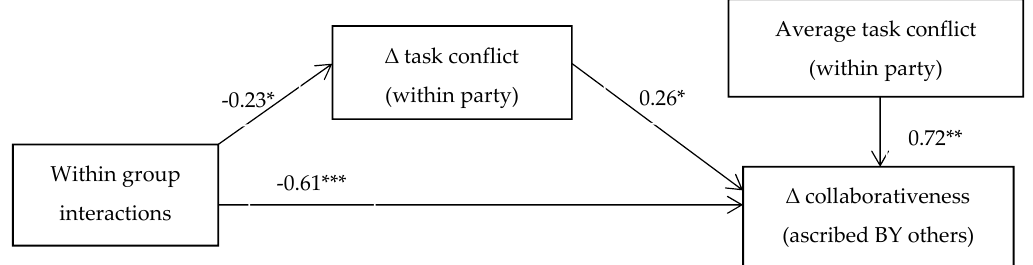
Figure 3. The overall mediation model for change in tach conflict and collaborativeness (bottom-up influence). Notes: * p < 0.05; ** p < 0.01, *** p < 0.001, Δ task conflict = task conflict at time 2 minus task